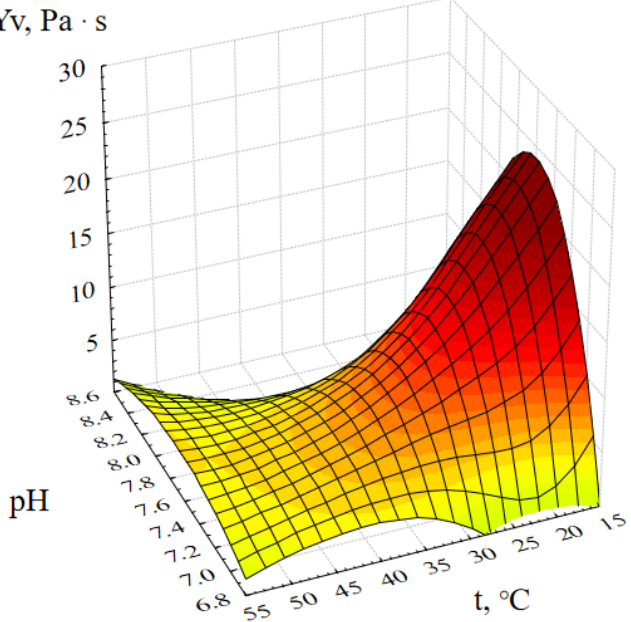
Figure 4. Response surface of the output parameter Y v (dynamic viscosity of the ZnO gel) depending on the active acidity and temperature of the reaction medium.